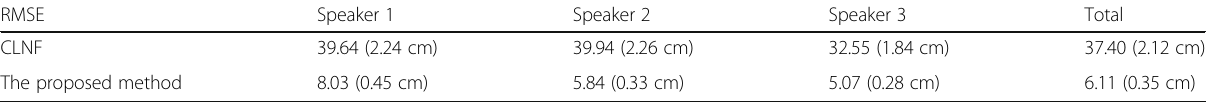
Table 3 Total error values for original CLNF model and the periodical spline interpolation method (expressed in pixels and cm)